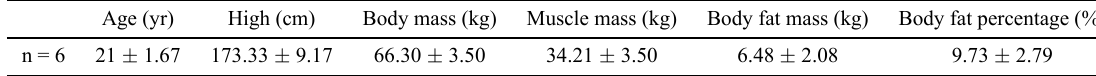
Table 1. Physical characteristics of participants (Mean Values ± SD).